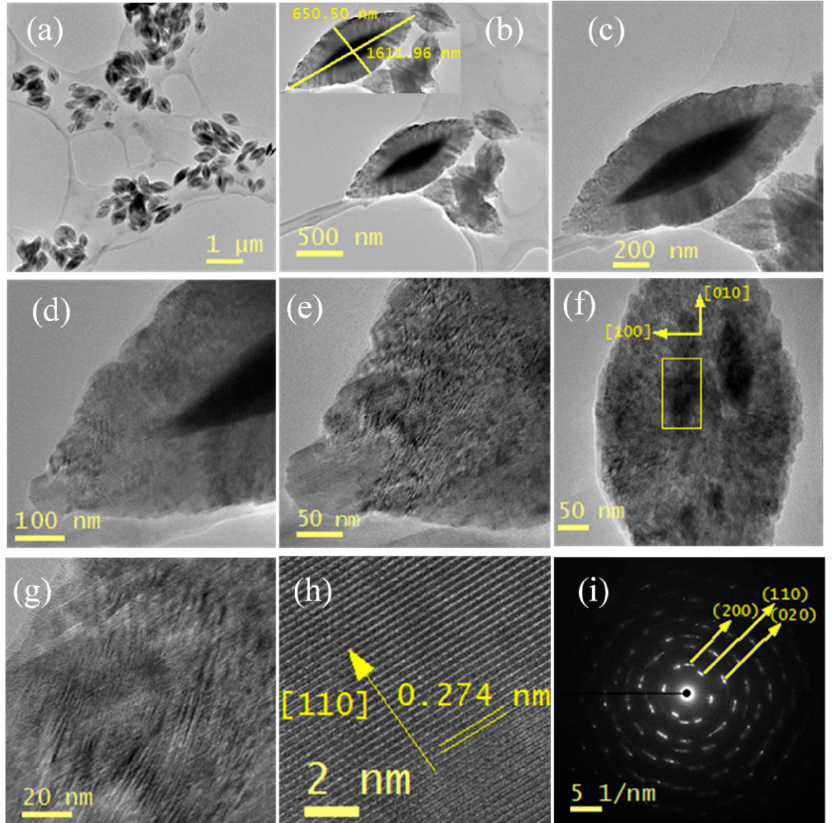
Figure 5. High resolution transmission electron microscope (HR-TEM) and selected area electron diffraction (SAED) analysis of CuO nanopetals: ( a ) large scale and well-defined monodispersed CuO nanopetals image on TEM grid. ( b , c ) TEM image of well-stabilized single CuO nanopetal, showing their length and diameter. ( d – g ) HR-TEM image of single nanopetal with growth direction exhibiting sharp tips with the clear and smooth surfaces. ( h ) d-spacing of single CuO nanopetal. ( i ) SAED analysis taken from the rectangle part in Figure 5.